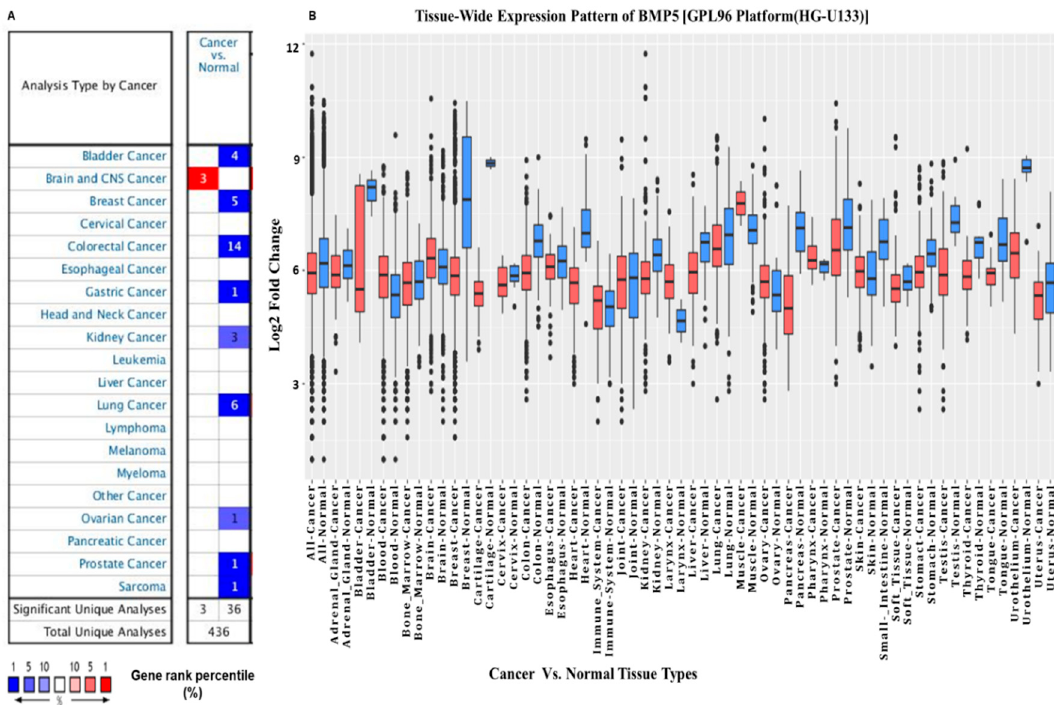
Figure 1. Bone morphogenetic protein 5 ( BMP5 ) transcription level in di ff erent types of cancer derived from the ONCOMINE and Gene Expression across Normal and Tumor Tissue (GENT) databases. ( A ) This graphic was generated from the ONCOMINE database, indicating the number of datasets with statistically significant ( p < 0.01) mRNA overexpression (red) or down-regulation (blue) of BMP5 (di ff erent types of cancer vs. corresponding normal tissue). The threshold was designed with the following parameters: p -value of 1 × 10 − 4 , fold change of 2, and gene ranking of 10%. ( B ) BMP5 mRNA expression pattern in normal and tumor tissues. BMP5 mRNA expression in various types of cancer was obtained from the GENT database. X-axis exhibits log2 fold change values of BMP5 expression whereas, Y-axis shows the types of tissues BMP5 were expressed. Boxes represent the median and the 25th, and 75th percentiles dots represent outliers. Red boxes represent tumor tissues; blue boxes represent normal tissues. Red and blue dashed lines represent the average value of all tumor and normal tissues, respectively.